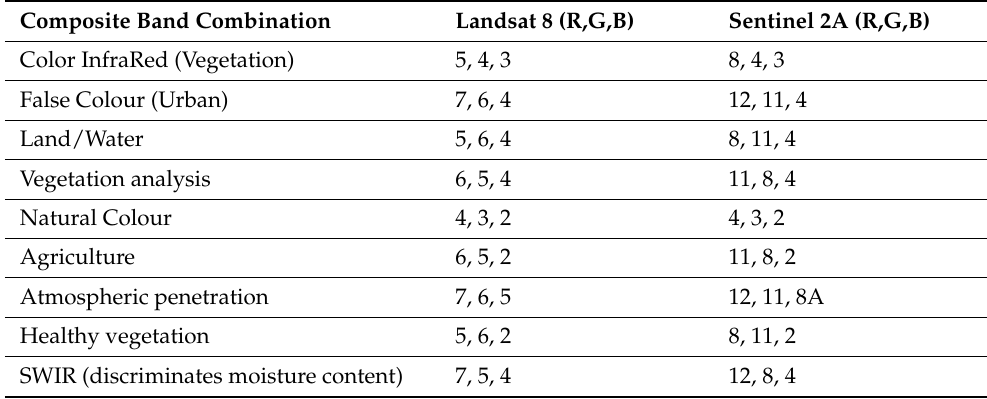
Table 2. The output color composite band combinations were as illustrated in this table from the comparisons and translations between Landsat 8 colour composites and Sentinel